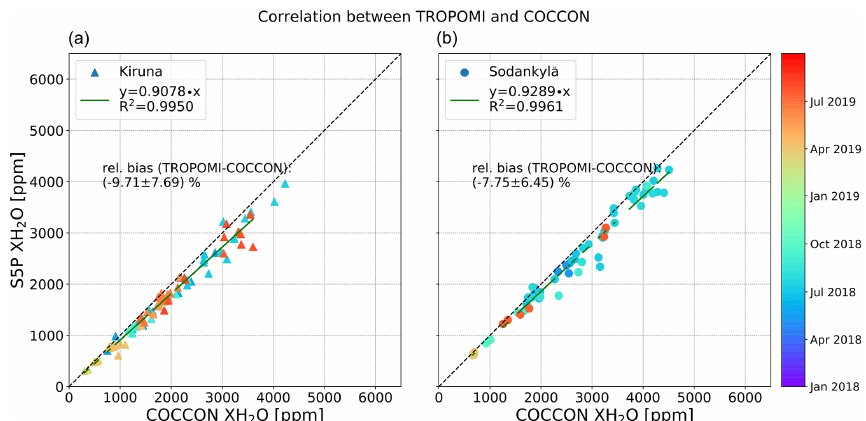
Figure 12. Correlation plots of TROPOMI and COCCON XH 2 O at the Kiruna site (a) and the Sodankylä site (b) . The annotations follow those in Fig. 2. Note that the color bar is from January 2018 to October